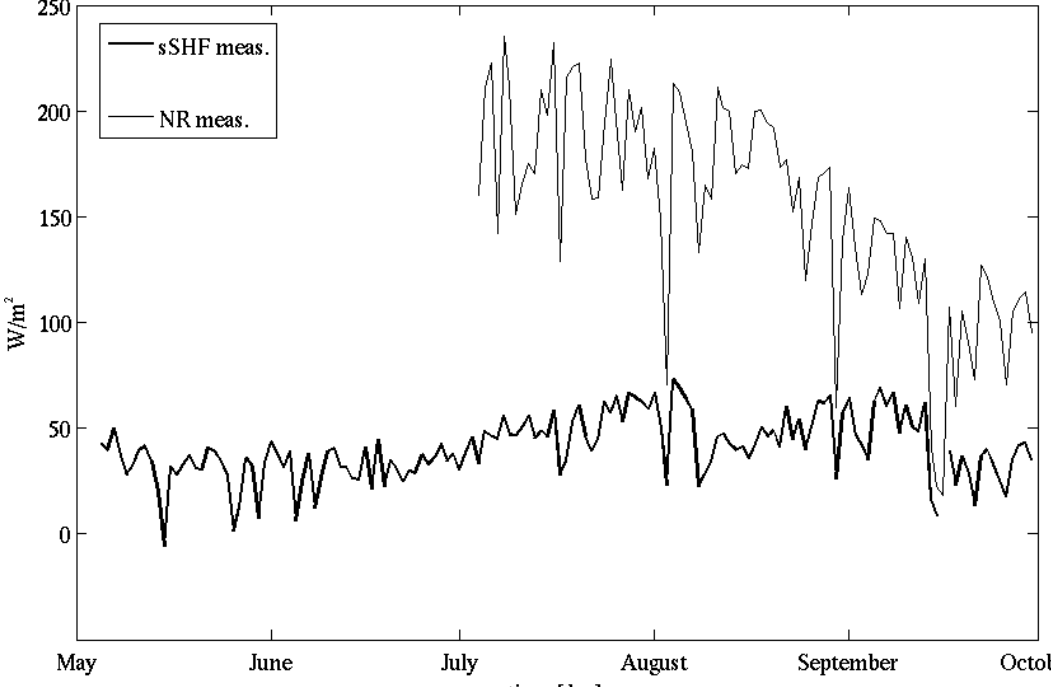
Figure 7. Mean daily net radiation (thin line), measured at the flank of the vineyards, and “sonic” sensible heat flux (thick line), evaluated by sonic anemometer measurements above the vineyards, relative to Cocconato during the 2009 growing season (both in Wm -2